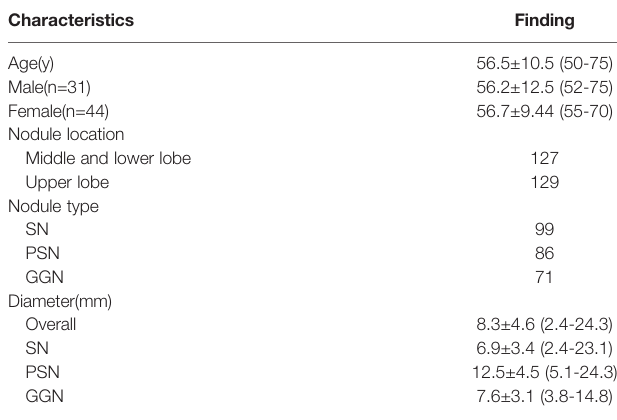
TABLE 1 | Patient